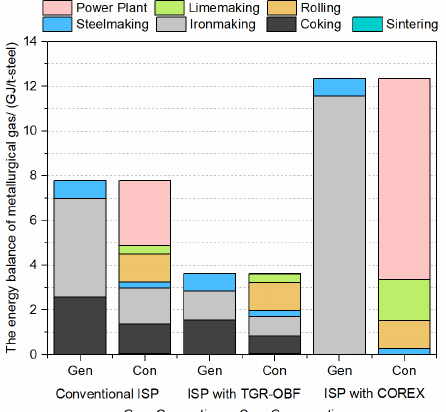
Figure 7. The metallurgical gas balance in the conventional ISP, ISP with the TGR-OBF, and ISP with the COREX.